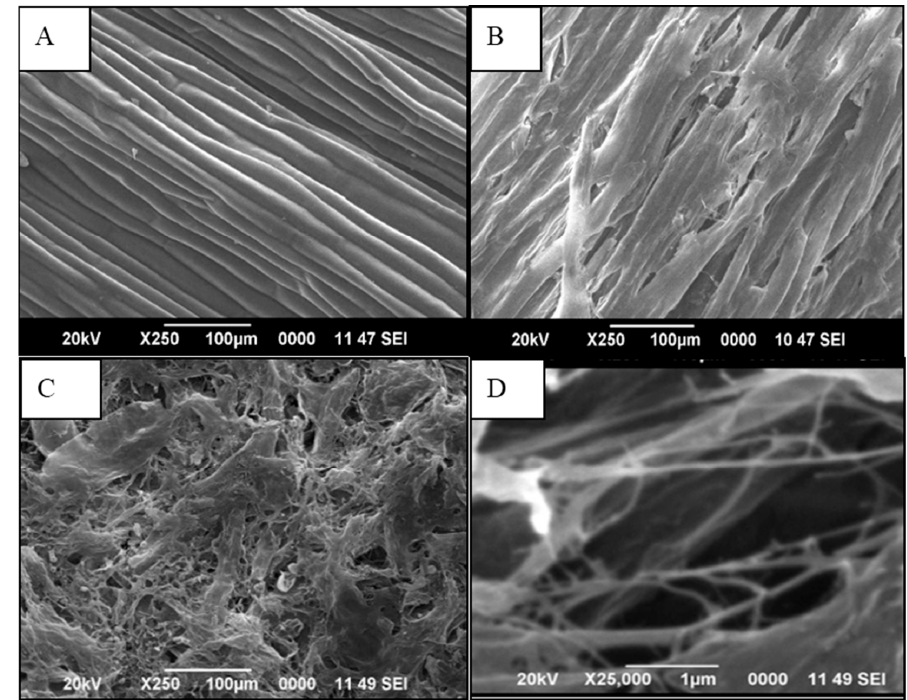
Figure 3. Scanning Electron Microscopy (SEM) images of ( A ) raw Cuscuta reflexa, ( B ) alkali-treated Cuscuta reflexa, and ( C ) and ( D ) CNF, under two different magnifications (×250 and ×25,000).